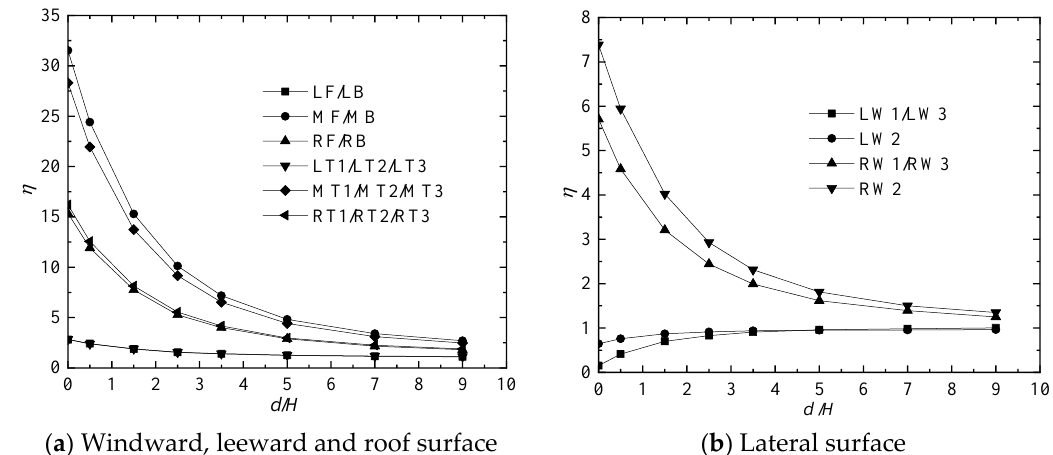
Figure 17. Relative value of wind pressure coefficient in valleys to that in plains area considering 90° greenhouse azimuth. Table 6. Distribution coefficient of wind pressure on each shed surface when the shed azimuth angle in the plain area is 45°.